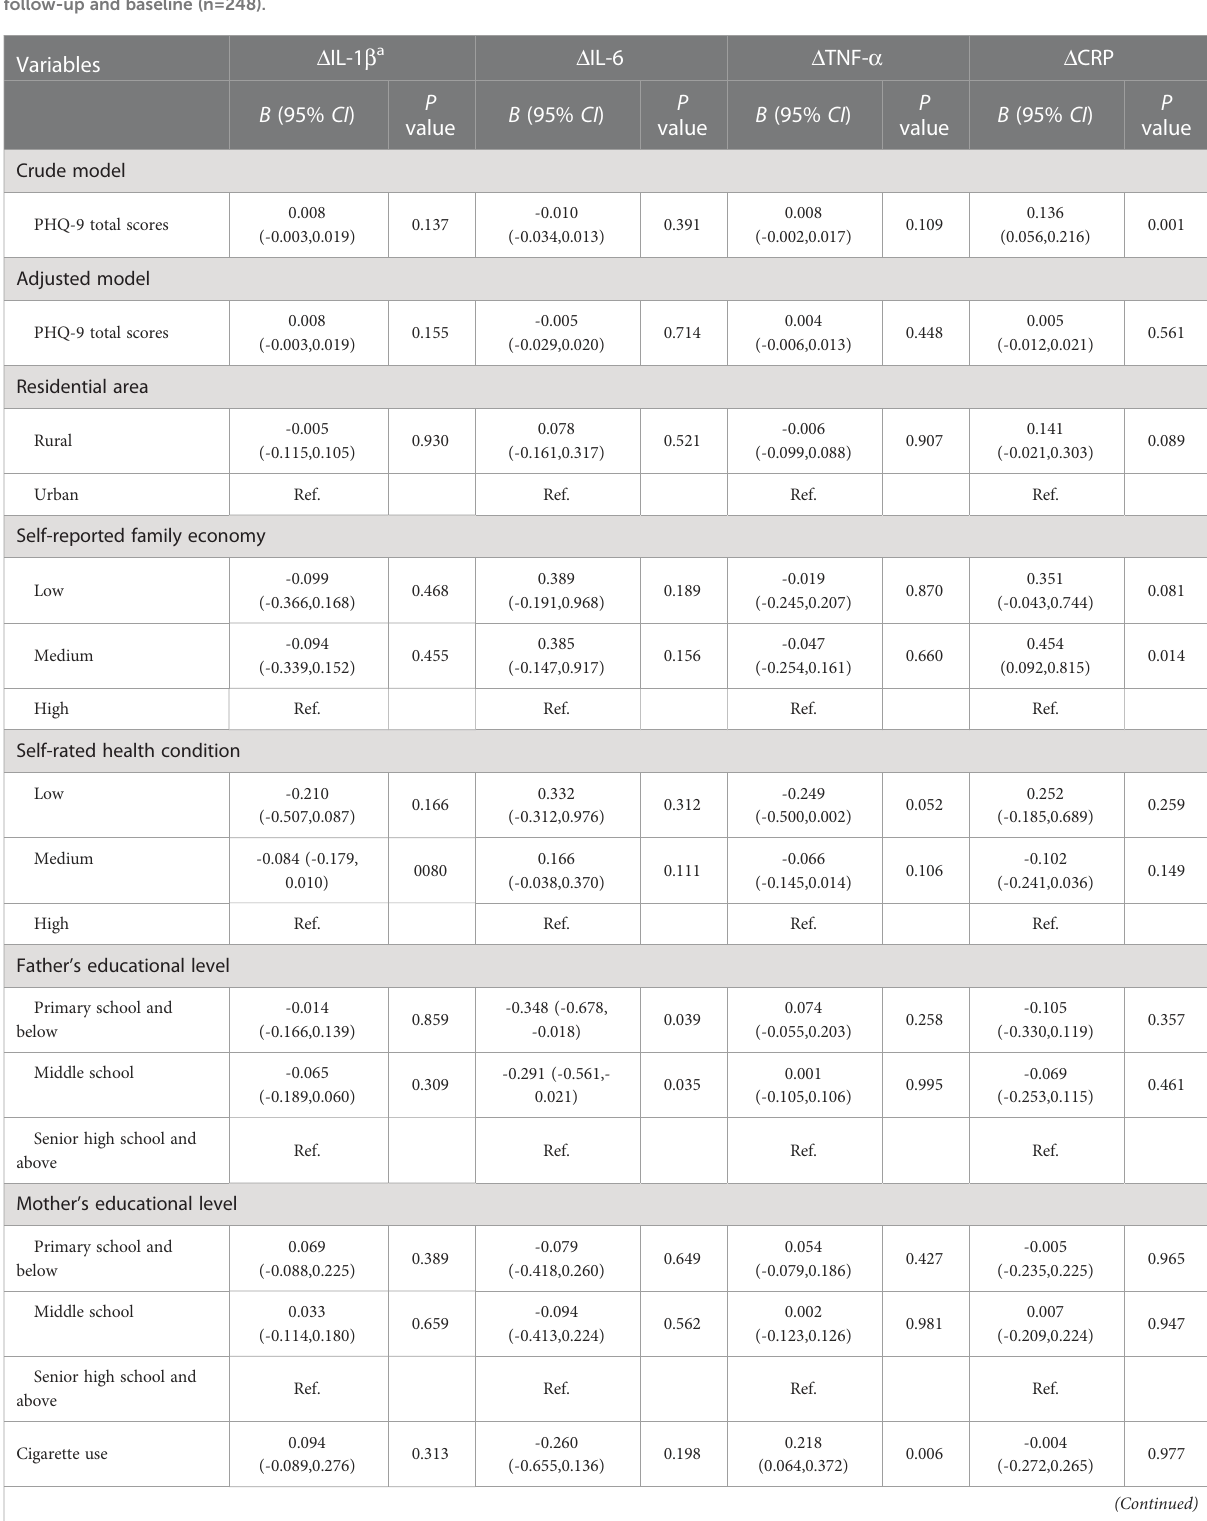
TABLE 4 Generalized linear models of the associations between PHQ-9 total scores at baseline and changes in in fl ammatory biomarkers between follow-up and baseline